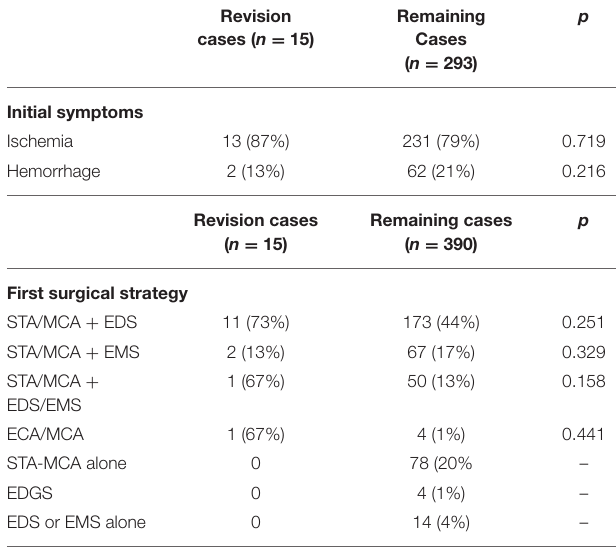
TABLE 1 | Demographics and disease characteristics in revision cases and total cases.